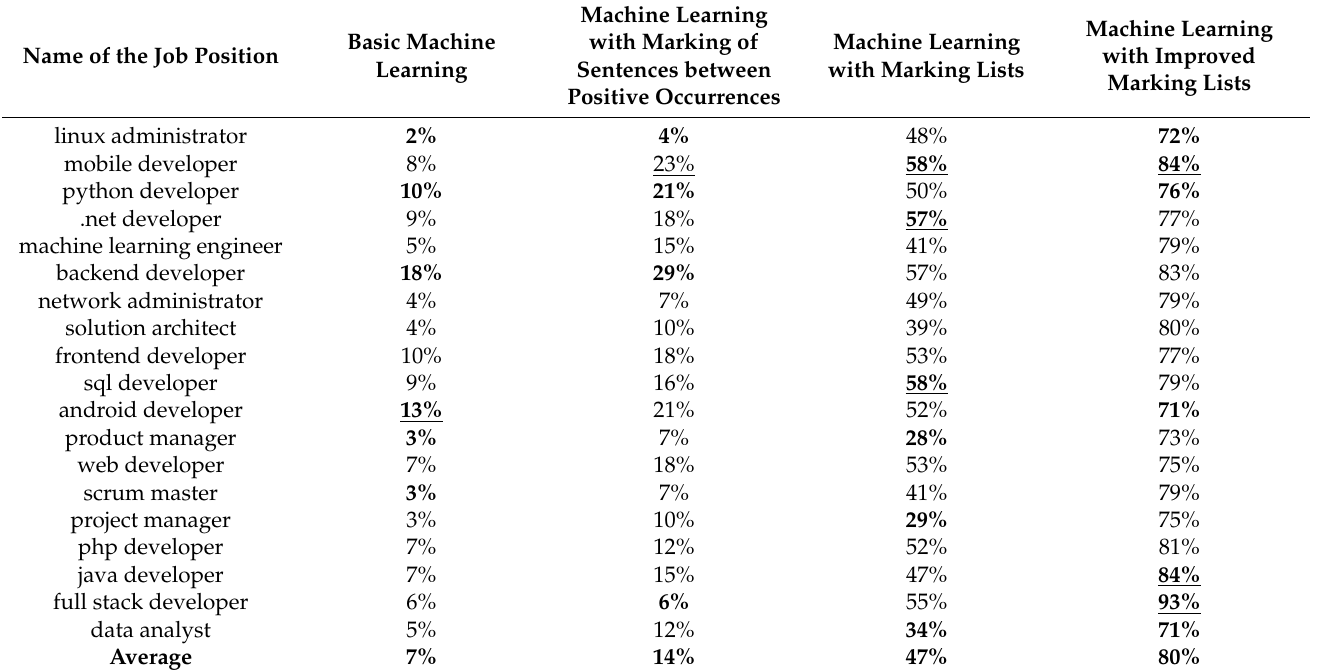
Table 6. Comparison of individual approaches.